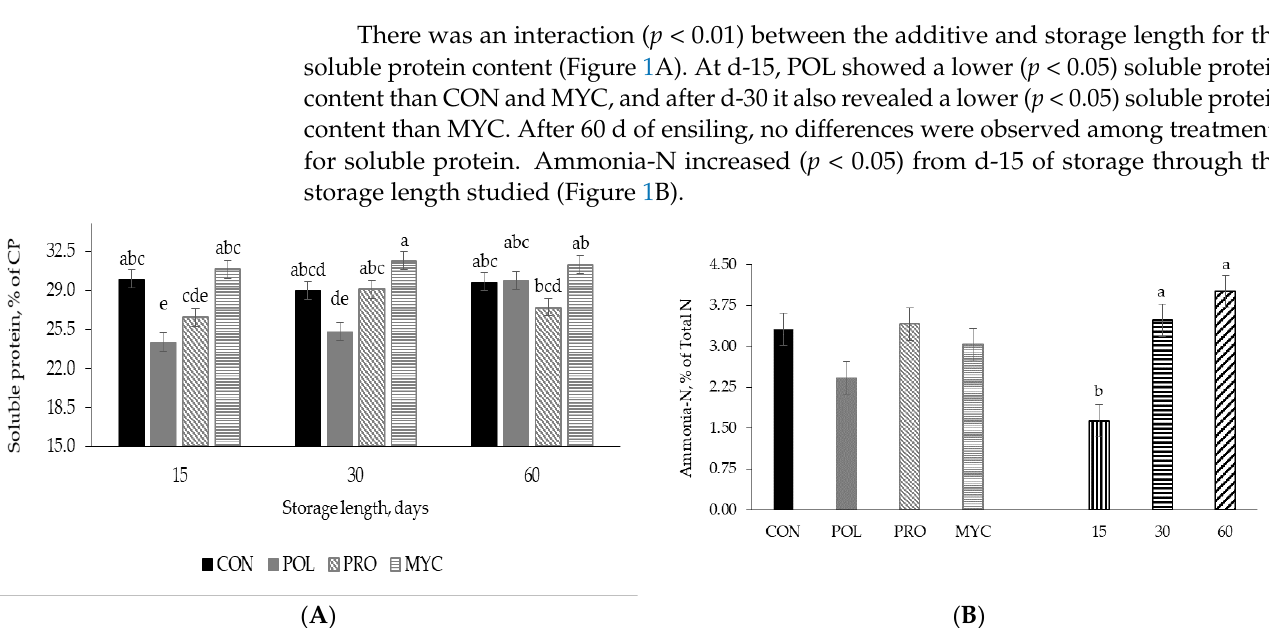
Figure 1. Nitrogenous fractions of reconstituted corn grain silage ensiled for 15, 30 or 60 d, without additives treatment (CON) or treated with polysorbate 80 (POL), propionic acid (PRO) or polysorbate 80 and propionic acid (MYC). Statistical effects observed for ( A ) Soluble protein – Additive, p < 0.01; Storage, p = 0.03; effect of the interaction between additive and storage length (A × S), p < 0.01; SEM = 0.81, ( B ) Ammonia-N – Additive, p = 0.06, SEM = 0.27; Storage, p < 0.01, SEM = 0.28; A × S, p = 0.08. Different letters differ by Tukey’s test ( p ≤ 0.05). The length of storage and additives altered the kernel particle size distribution (Table